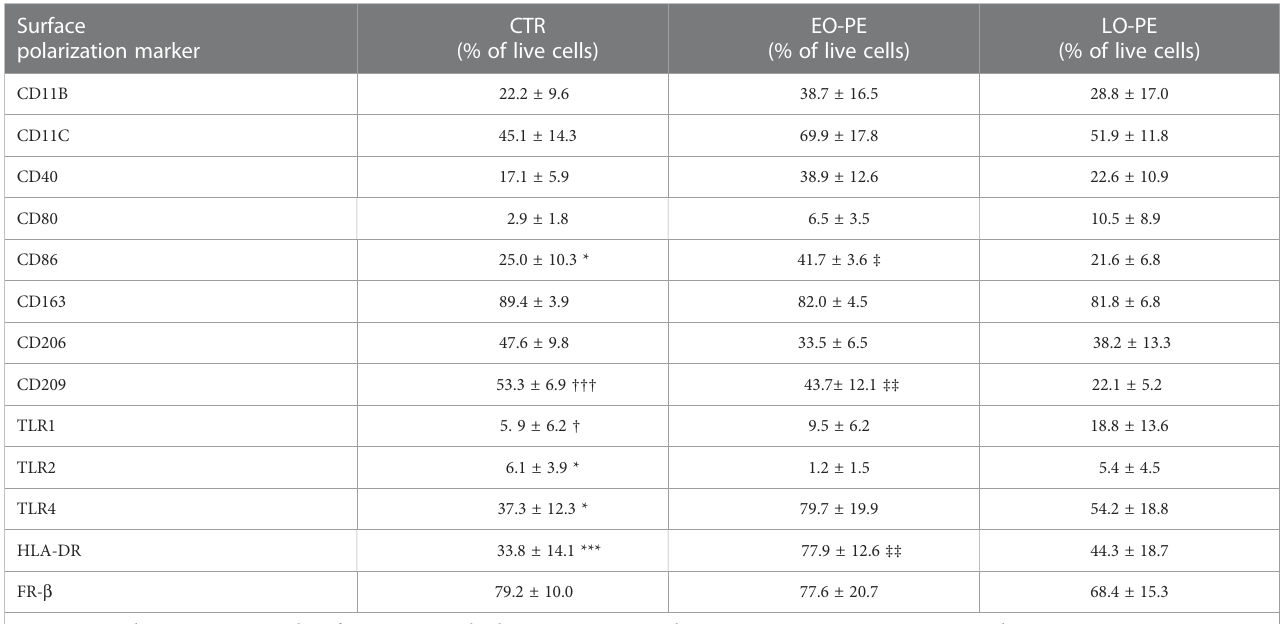
TABLE 2 Percentage of live cells positive for respective surface polarization markers within the CTR (n=12), EO- (n=6) and LO-PE (n=5)